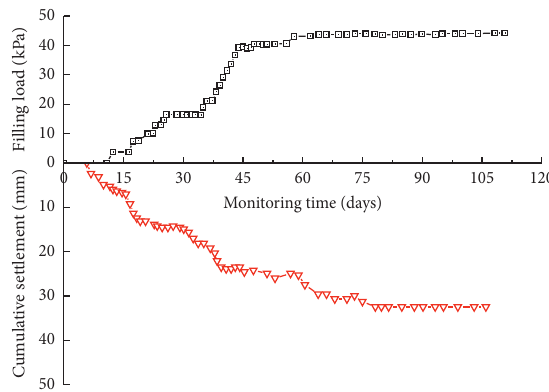
Figure 19: Variation of cumulative settlement with filling load.